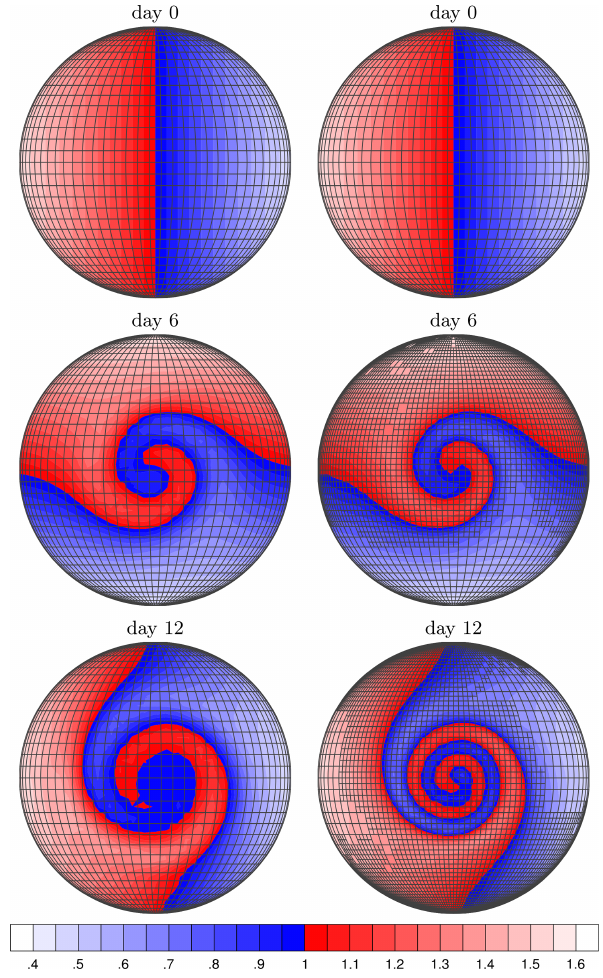
Figure 18. Numerical results of the moving vortices test case. The left column shows the numerical results on the a resolution of a 5 ◦ × 5 ◦ coarse grid. The right column shows the numerical results on the resolution of a 5 ◦ × 5 ◦ coarse grid with one-level refinement and an interpolated wind